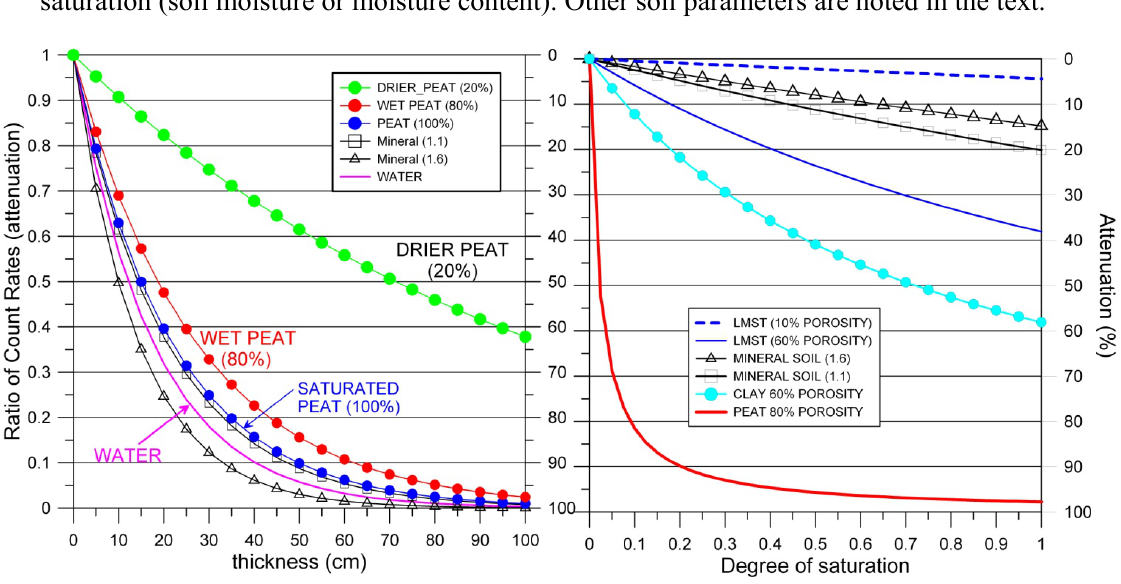
Figure 2. Theoretical attenuation behaviour of soil/bedrock types. The parameters defining the soil types are discussed in the text. ( a ) Variation with thickness assuming a uniform half-space. A 90% attenuation level provides a reference level. ( b ) Variation with degree of saturation (soil moisture or moisture content). Other soil parameters are noted in the